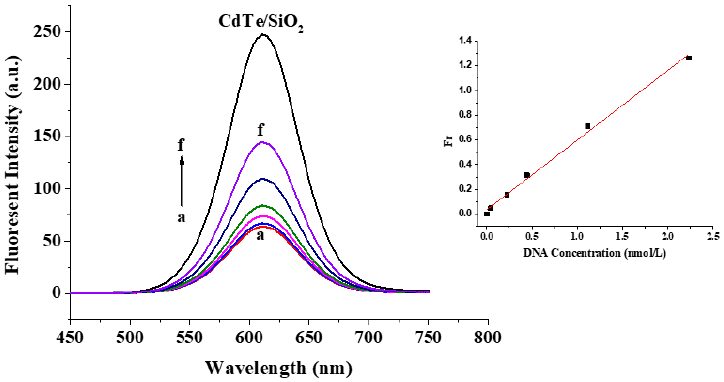
Figure 7. Detection of target DNA with different concentrations and the corresponding working curve: ( a ) 0 nmol/L; ( b ) 0.0446 nmol/L; ( c ) 0.223 nmol/L; ( d ) 0.446 nmol/L; ( e ) 1.115 nmol/L; and ( f ) 2.230 nmol/L.